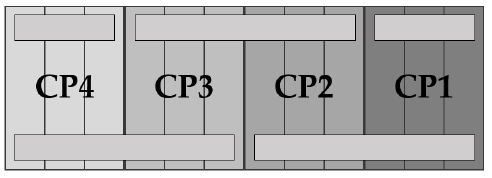
Figure 1. Schematic representation of the cell interconnection in the battery module showing the parallel connection results of 3 cells in a cell pack (CP).